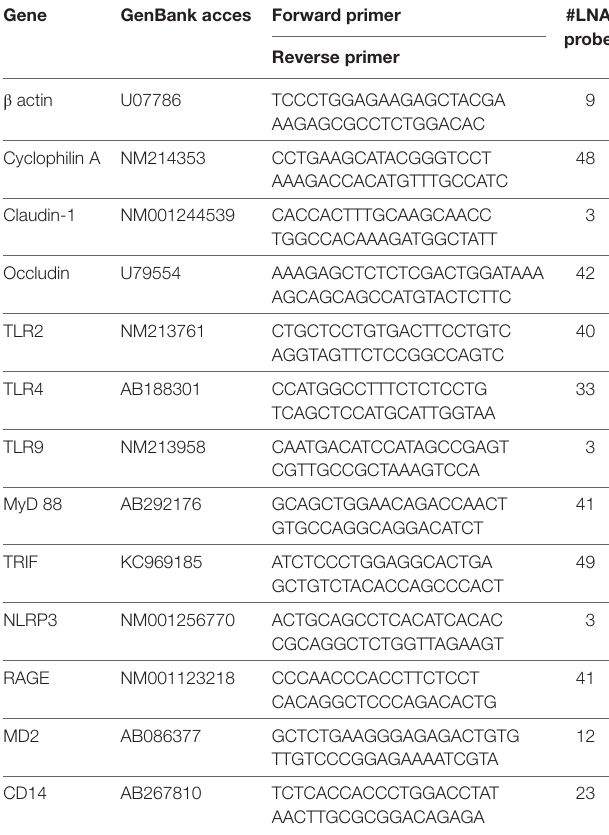
TaBle 1 | Locked nucleic acids based real-time PCR systems used in